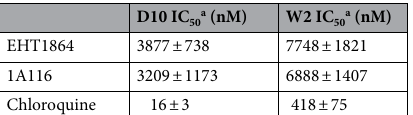
Table 1. In vitro antiplasmodial activity of EHT1864 and 1A116. a The results are expressed as IC 50 ± SD of at least three independent experiments each performed in